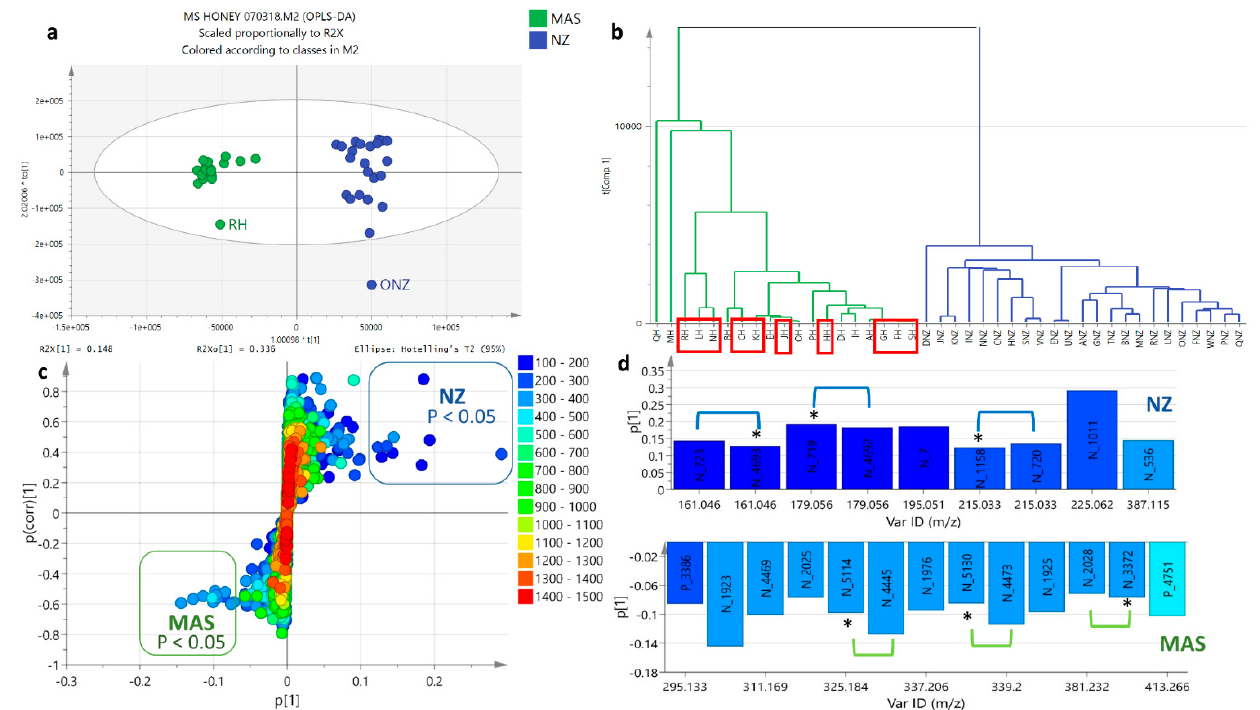
Figure 6. OPLS model employing the mass spectral dataset. Bioactive extracts were boxed in red. ( a ) OPLS-DA scores plot (R 2 = 0.91 and Q 2 = 0.64). Permutation test generated a Q 2 Y = − 0.355. ( b ) HCA by single linkage, ( c ) S-loadings plot of mass spectral data of honey extracts, and ( d ) Coefficient bar graph showing the discriminating metabolites with p < 0.05 as boxed on the S-plot. * Due to identical RT and m/z values with another variable feature, only the one with a higher p value was included in Table 2. Legend: MAS (Malaysian samples), NZ (New Zealand samples).